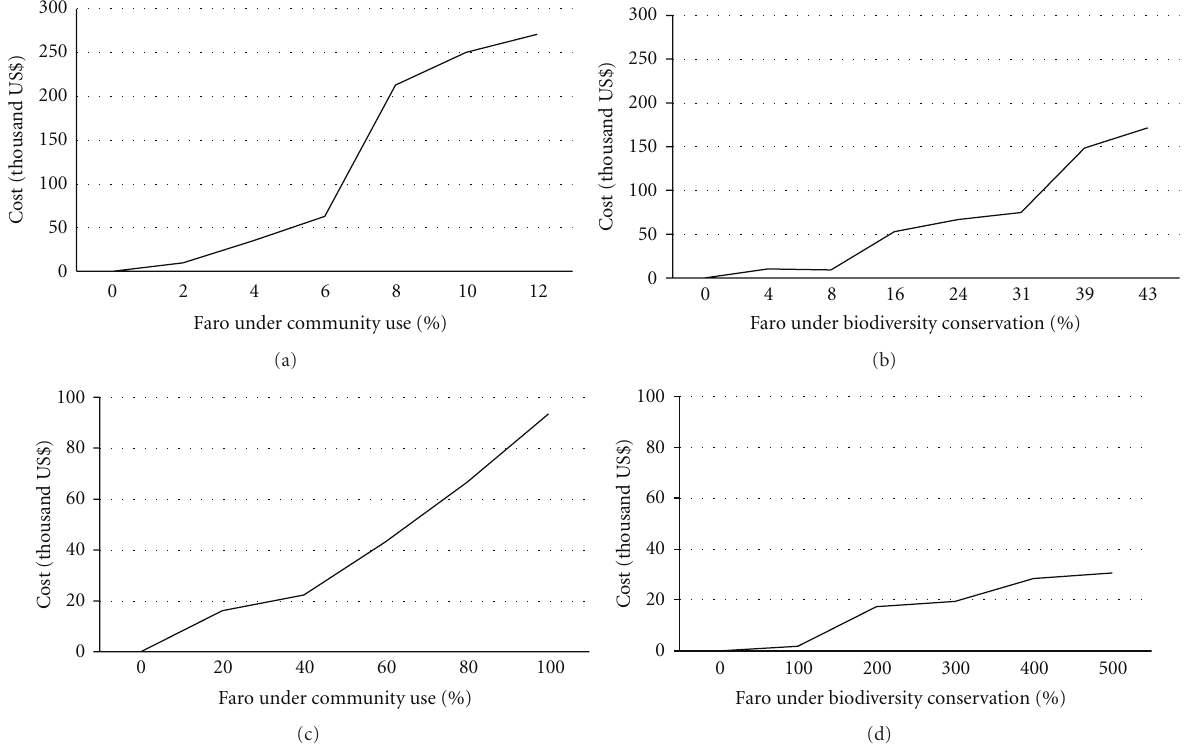
Figure 6: Marginal opportunity costs for community use (a) and biodiversity conservation (b), assuming stands are weighted equally for nonlogging land uses within Faro State Forest; marginal opportunity costs considering di ff erent weights among stands for nonlogging land uses for community use (c) and biodiversity conservation (d). Harvests are assumed to be performed from current logging